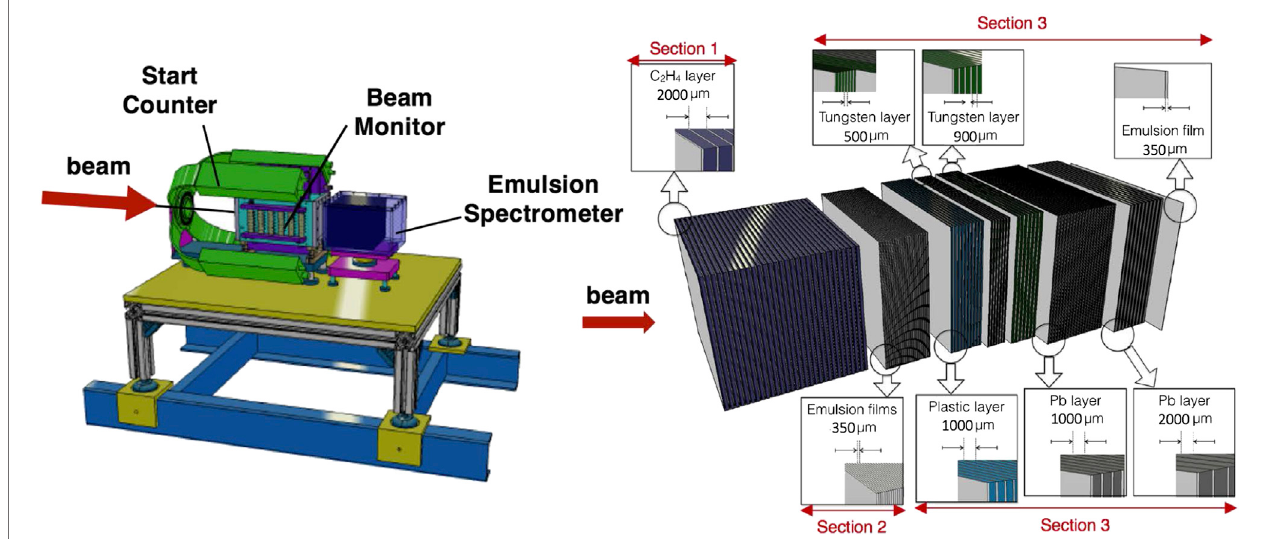
FIGURE 10 | (Left) Emulsion spectrometer setup placed downstream the SC and the BM. (Right) Scheme of the emulsion spectrometer composition with the C2H4 target.